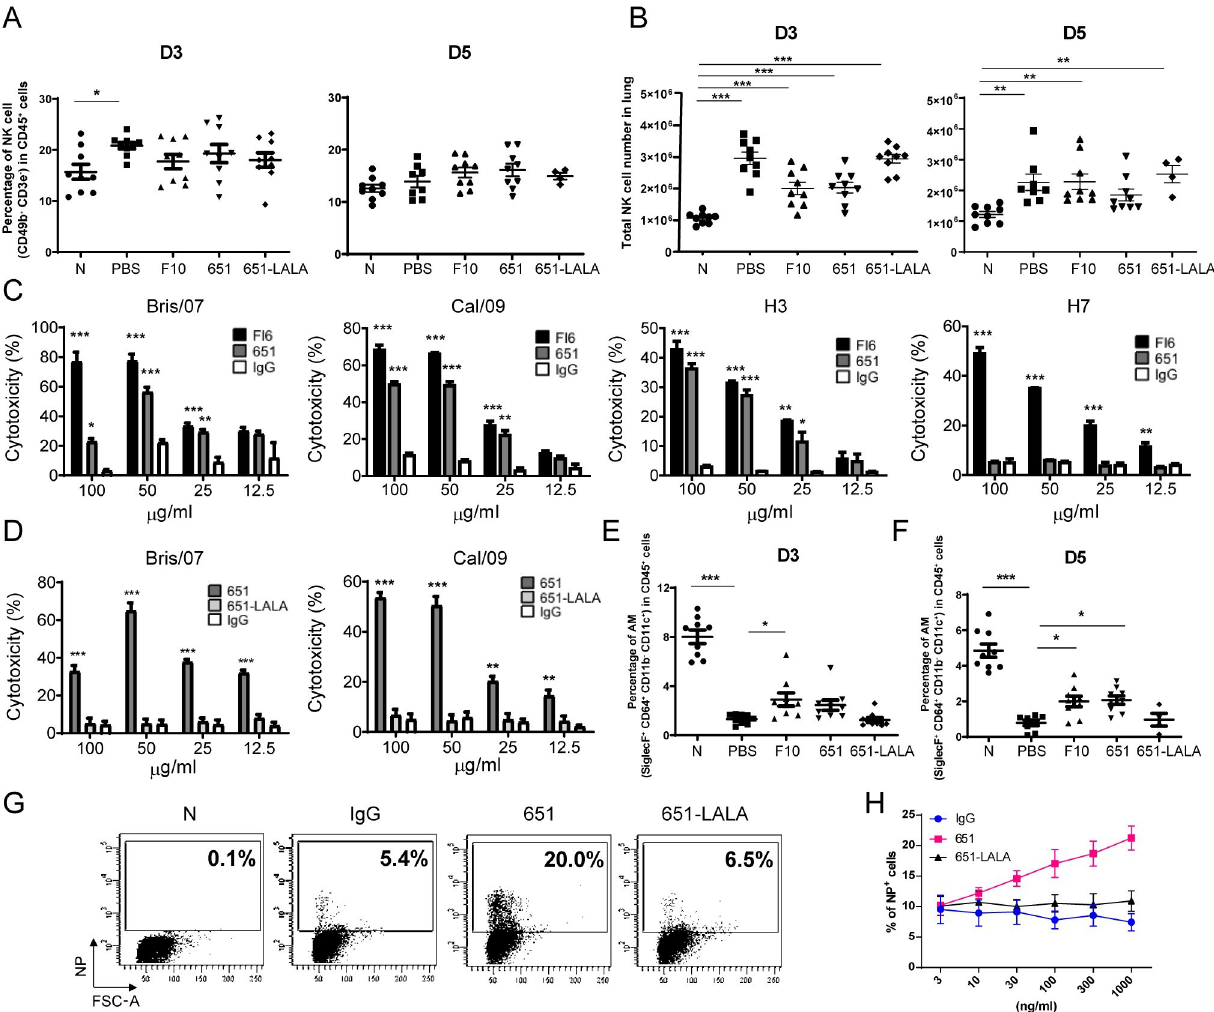
Fig 4. 651 possessed ADCC or ADCP against influenza viruses in vitro . (A and B) FACS analysis showing the percentage (A) and number (B) of pulmonary NK cells (CD49b + ) in CD45 + CD3e − -gated populations in indicated mAb-pretreated mice on day 3 and day 5 post challenge of Cal/09 virus. n = 4–9 mice per group in A and B. (C) 651 showed ADCC against H1 (Bris/07 and Cal/09) and H3 but not H7-expressing 293T cells. (D) 651-LALA mutation abolished ADCC mediated by 651 to kill cells expressing H1 from Bris/07 or Cal/09 viruses. IgG was used as the negative control in C and D. n = 3 in C and D. (E and F) FACS analysis showing the percentage of alveolar macrophages (AMs) (SiglecF + CD64 + ) in CD45 + CD11b − CD11c + gate in indicated mAb- or PBS-pretreated mice on day 3 (E) and day 5 (F) post-challenge with Cal/09 virus. n = 9 mice per group in E and n = 4–9 mice in F. (G) FACS showing the NP positive signals in sialidase (0.5 unit/mL) treated THP-1 cells incubated with 651-, 651-LALA-, or IgG- (all at 100 ng/mL) opsonized Cal/09 virus. Percentage of NP positive cells is indicated. (H) FACS results showing the percentage of NP positive signals in sialidase treated THP-1 cells incubated with serial doses of 651 or 651-LALA mAbs and Cal/09 virus. n = 4 in IgG and 651-LALA groups and n = 5 in 651 group. N represents na ï ve mice without infection. Results are mean ± SEM. � p < 0.05; �� p < 0.01; ��� p < 0.001.